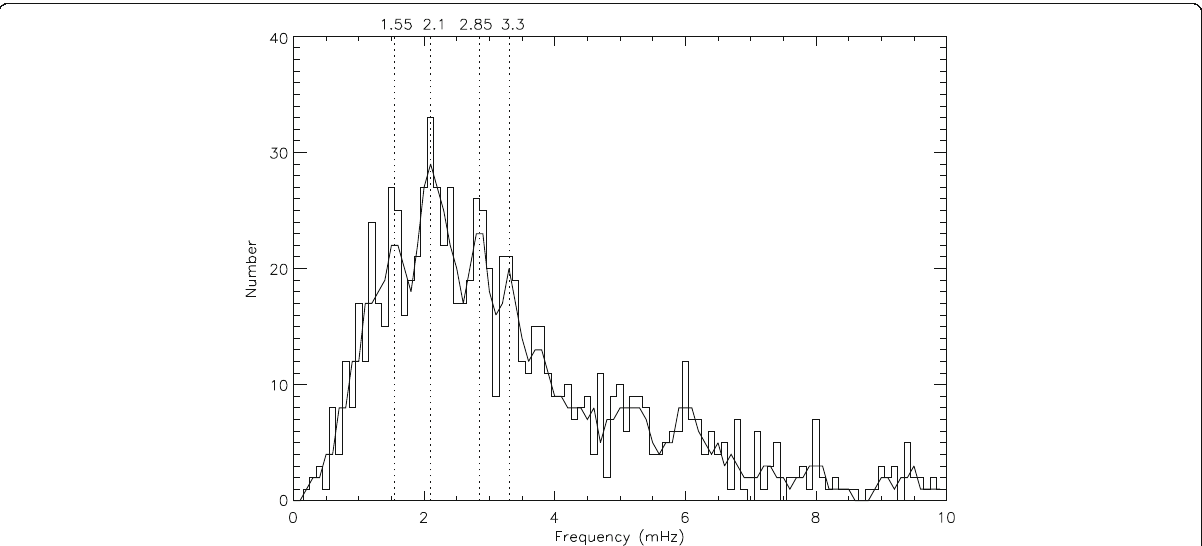
Fig. 37 A histogram of significant frequencies in the TIG data set. A three-point smoothing is applied to the data and is shown by the curve with the slightly darker black line superimposed on the histogram. The vertical lines identify peaks of the smoothed curve showing certain frequencies at 1.3, 1.6, 2.1, 2.9, and 3.3 mHz which appear to have higher spectral power than the neighboring frequencies. The frequency resolution is 0.1 mHz. Reproduced from Fig. 7 of Norouzi-Sedeh et al.